Question: In a single sentence, describe what this figure presents.
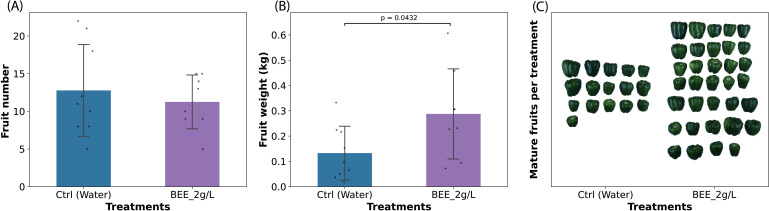
Answer: Effect of BEE treatment or control treatment on the yield of sweet pepper plants grown under growth room conditions. (A) The average fruit number (Ctrl n = 8; BEE n = 9). (B) The total fresh weight of all fruits per treatment. (C) Pictures comparing the mature fruits from the treated and untreated groups. All graphs are presented with error bars indicating standard deviation. Statistical significance (n = 8–9, p = 0.05) was determined using a t-test. BEE, Belgian endive extract; Ctrl, control treated with water.